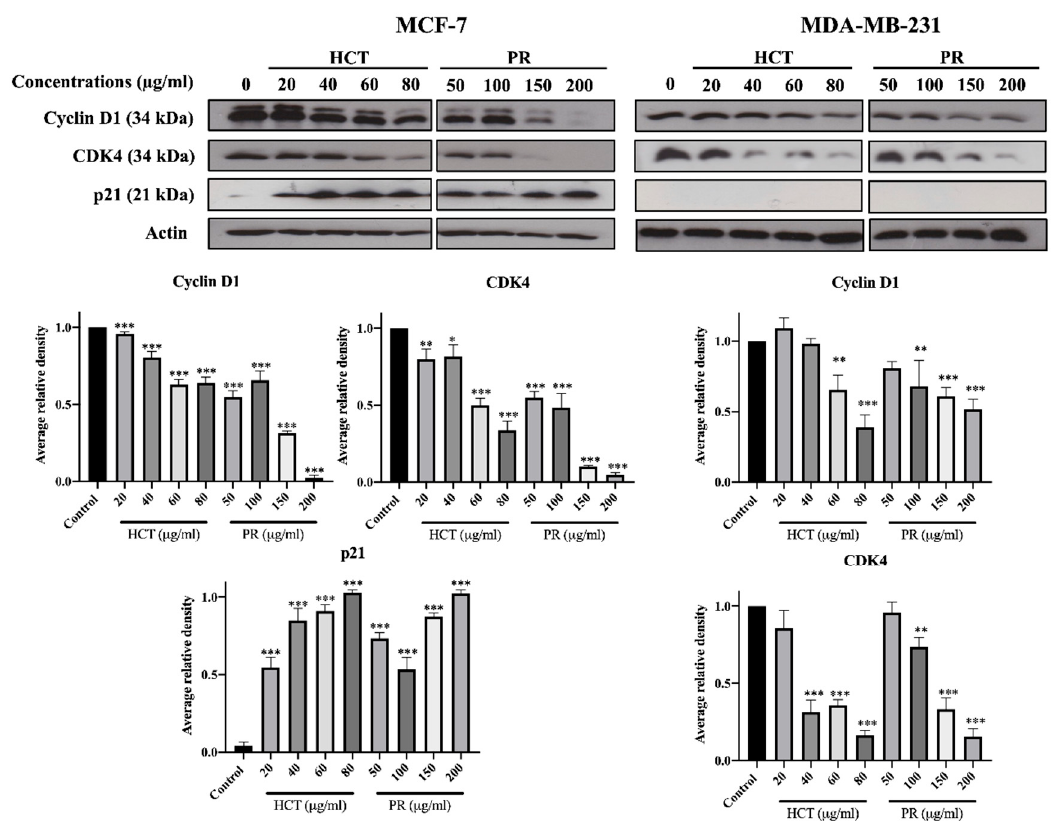
Figure 5. E ff ect of both H. cordata and P. ribesioides extracts inhibited cell cycle related protein expressions on breast cancer, by using Western blotting to investigate cyclin D1, CDK4, and p21. β -Actin acted as the loading control. Each value is presented as mean ± SD from three independent experiments. Data are the means ± SD. * p < 0.05, ** p < 0.01, and *** p < 0.001 vs. control.